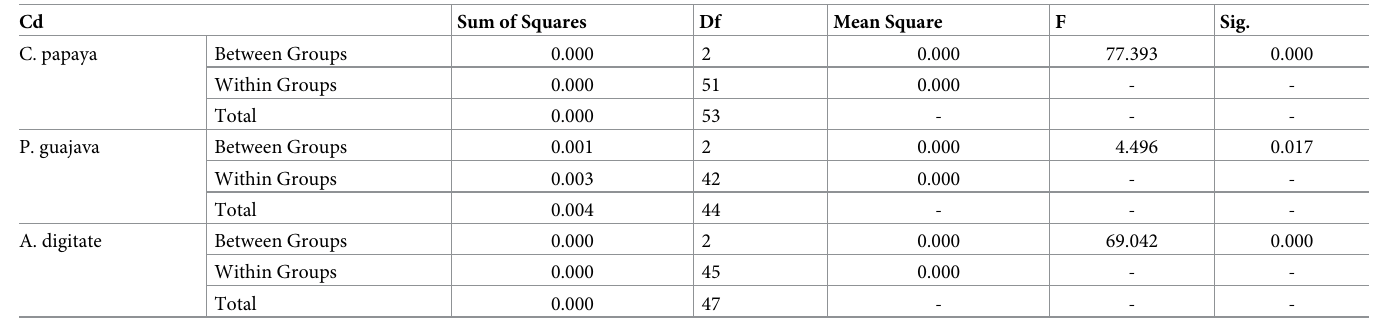
Table 7. ANOVA analysis table for Cd.